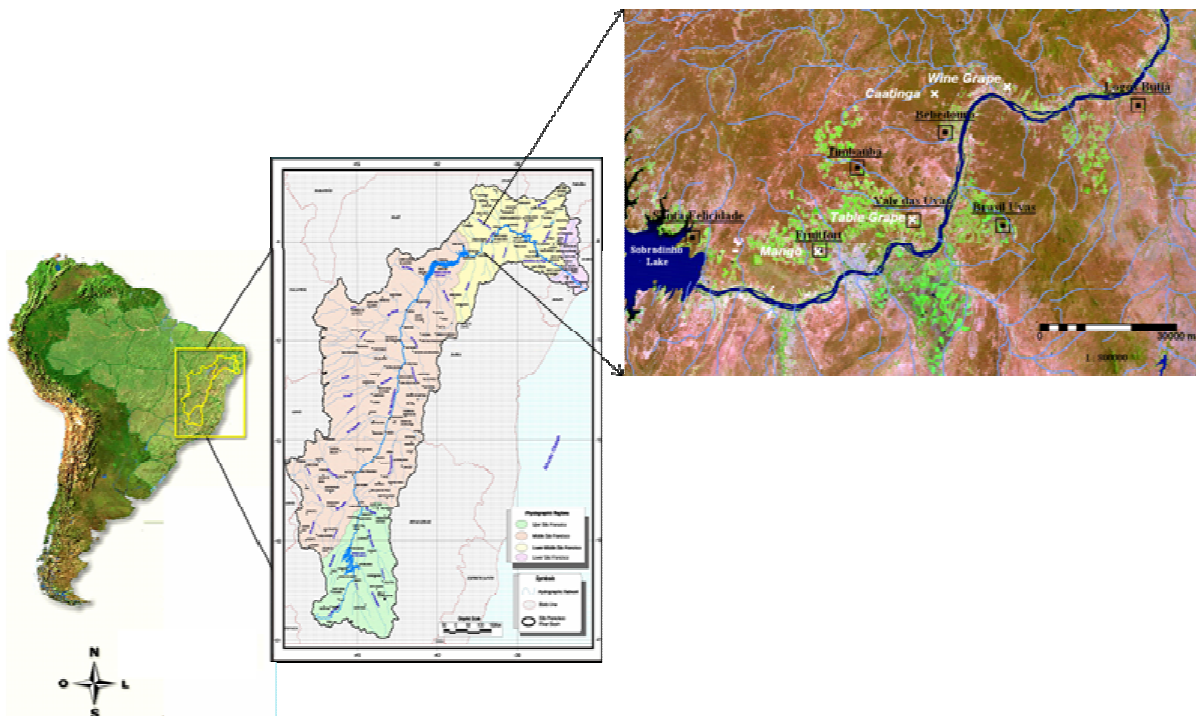
Table 3. Field energy balance experiments used for modeling actual evapotranspiration in the Low-Middle São Francisco river basin.